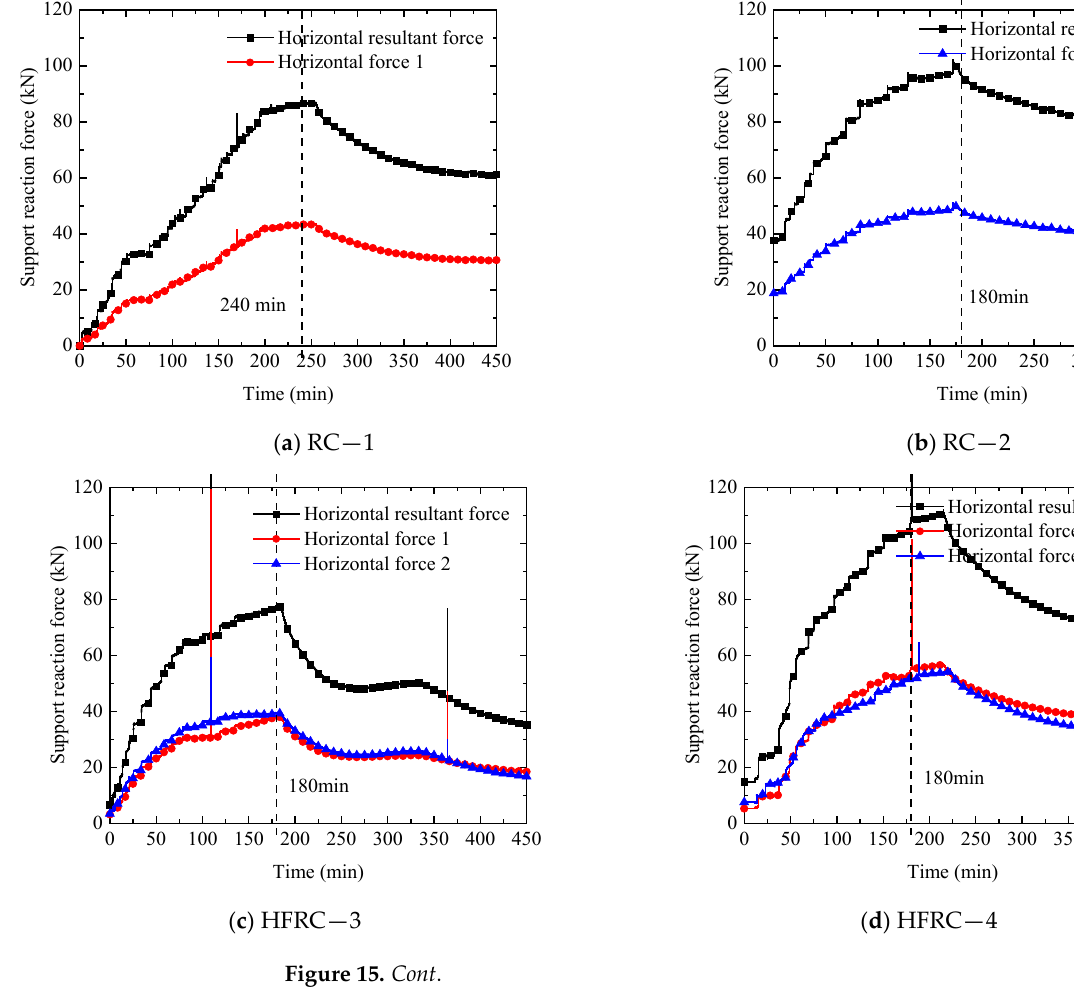
( e ) HFRC—5 Figure 15. Horizontal support reaction force–time curves: ( a ) RC—1; ( b ) RC—2; ( c ) HFRC—3; ( d ) HFRC—4; and ( e ) HFRC—5. 4. Conclusions This paper investigates the behavior of five concrete shield tunnel segments with two self-compacting concrete and three mixed-fiber (steel fiber and polypropylene fiber) self-compacting concrete segments subjected to fire. The main conclusions drawn are as follows: (1) The type of fiber and pre-loading have an important influence on crack develop- ment in concrete segments. Compared with undoped segments, cracks in segments with steel fibers and polypropylene fibers appear later, and the average crack spac- ing decreases. With the increase in the pre-loaded load, the number of cracks at a high temperature on the side of the segment increases significantly, and most of them are concentrated at the loading point. (2) Pre-loading has an important effect on the vertical deformation before and after the temperature rise. The initial load level has a great influence on the initial displace- ment and crack development. As the load level increases, so does the deformation after the temperature rise. Therefore, for segments with a deep buried depth, the steel bar at the bottom of the segment should be increased. (3) The existing fire protection code only takes temperature as the basis for determining the fire resistance limit of load-bearing structures in the tunnel, which is more